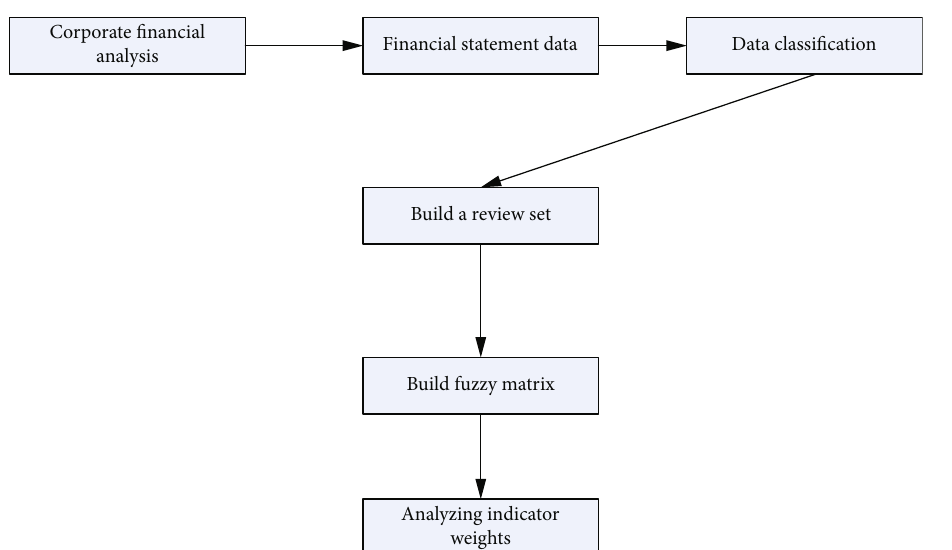
Figure 3: Flow chart of engineering science model based on fuzzy